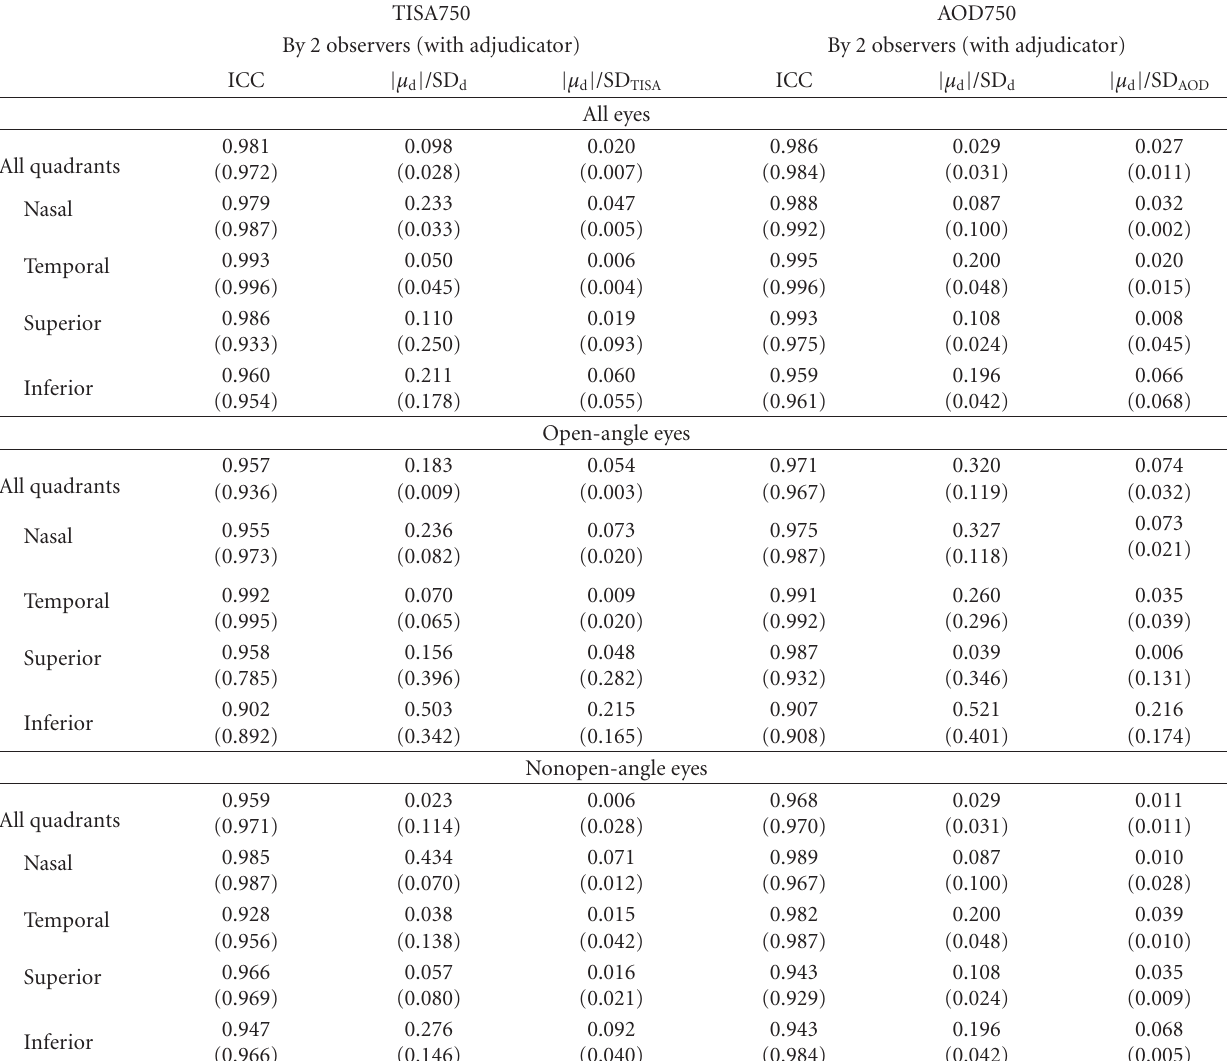
Table 7: Interobserver correlation coe ffi cient (ICC) for TISA750 and AOD750.